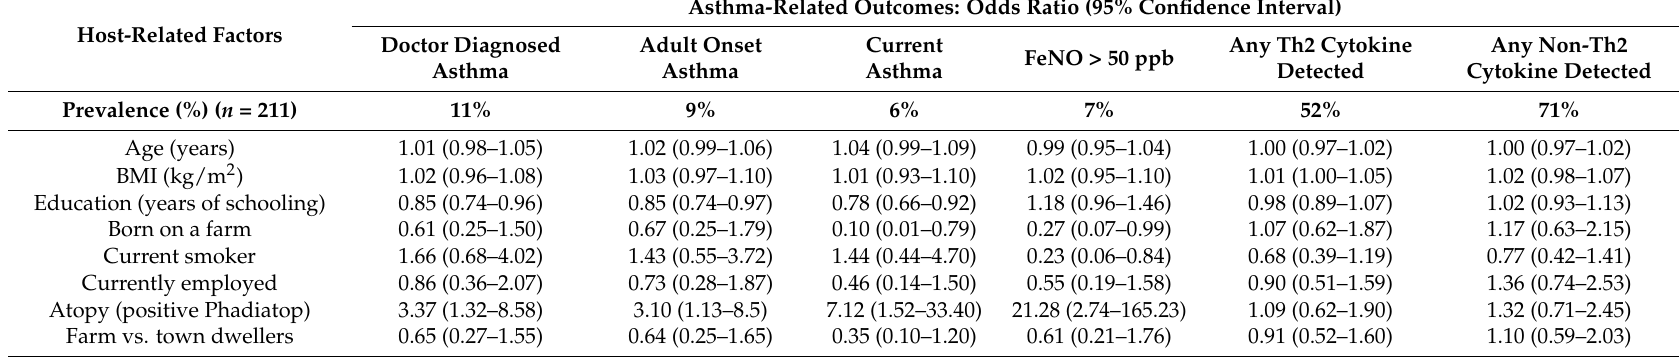
Table 4. Unadjusted logistic regression models of the association between host-related attributes and asthma-related outcomes among rural